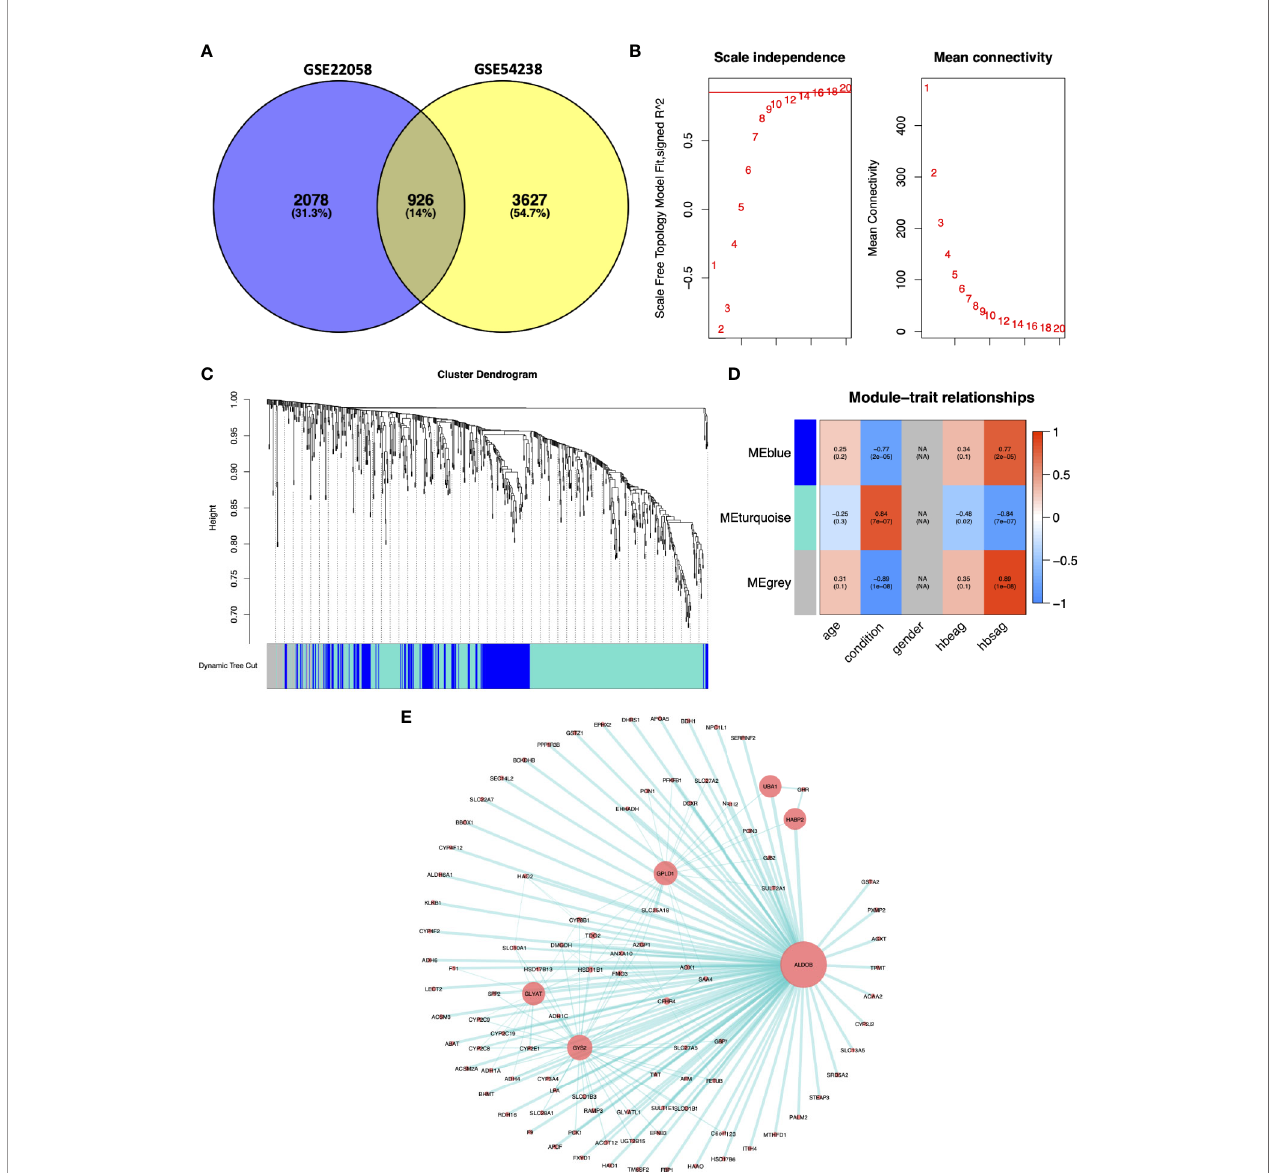
FIGURE 2 | Weighted gene coexpression network analysis. (A) Common DEGs between the GSE22058 and GSE54238 datasets are displayed. (B) Soft- thresholding for the adjacency matrix. (C) Hierarchical clustering-derived gene dendrogram. The dendrogram shows average linkage hierarchical clustering of DEGs. The colors under the dendrogram indicate the diverse modules. (D) Associations of modules with clinical characteristics. Modules denoted via diverse colors are presented along the vertical axis. Correlation coef fi cients were expressed as numbers at related positions, whereas p -values were presented in brackets with the coef fi cients. (E) Network visualization for the MEturquoise module. The node size was proportional to the connectivity degree. HBeAg, hepatitis B e-antigen; HBsAg, surface antigen of hepatitis B